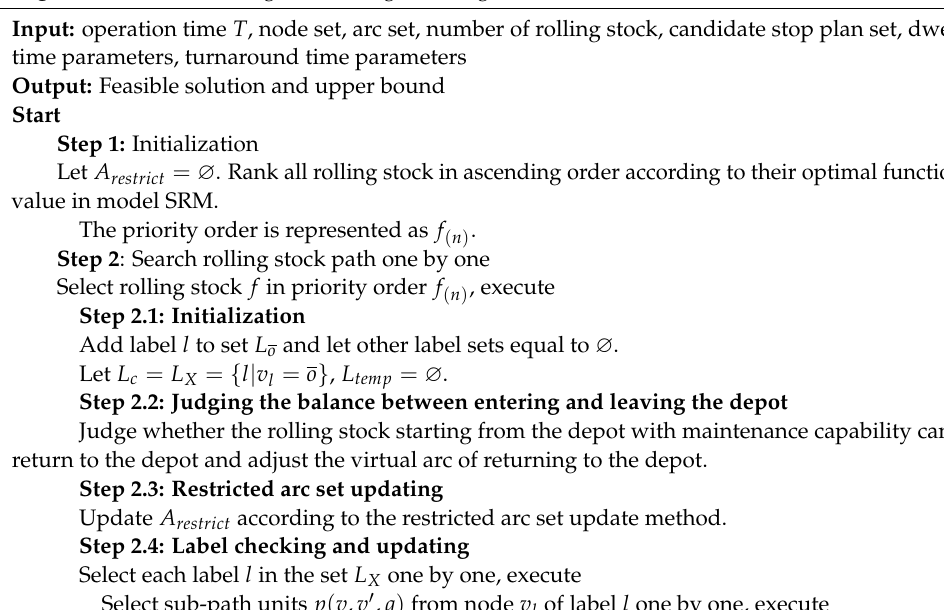
Algorithm 3: Heuristic algorithm for generating feasible